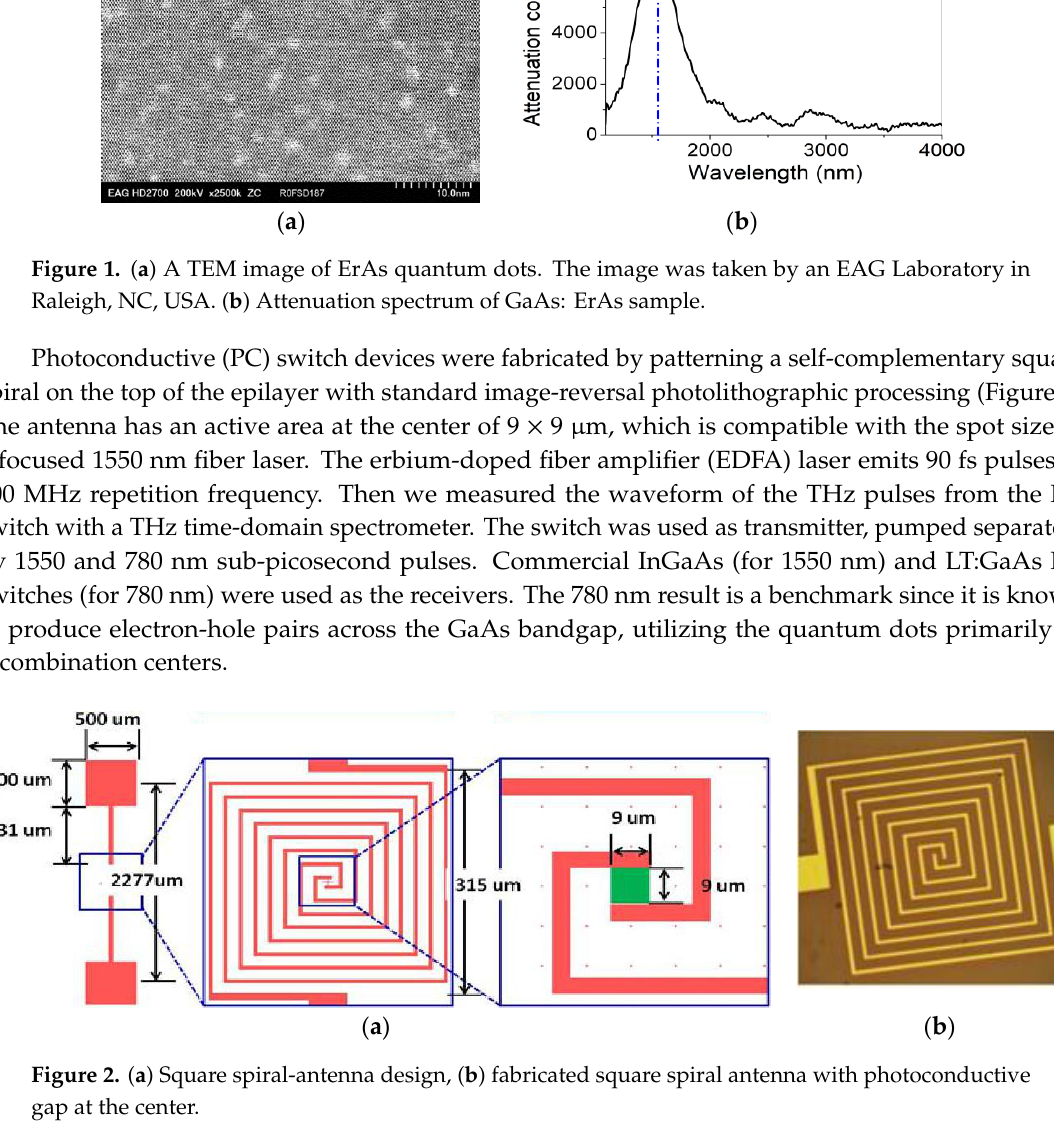
Figure 1. ( a ) A TEM image of ErAs quantum dots. The image was taken by an EAG Laboratory in Raleigh, NC, USA. ( b ) Attenuation spectrum of GaAs: ErAs sample.